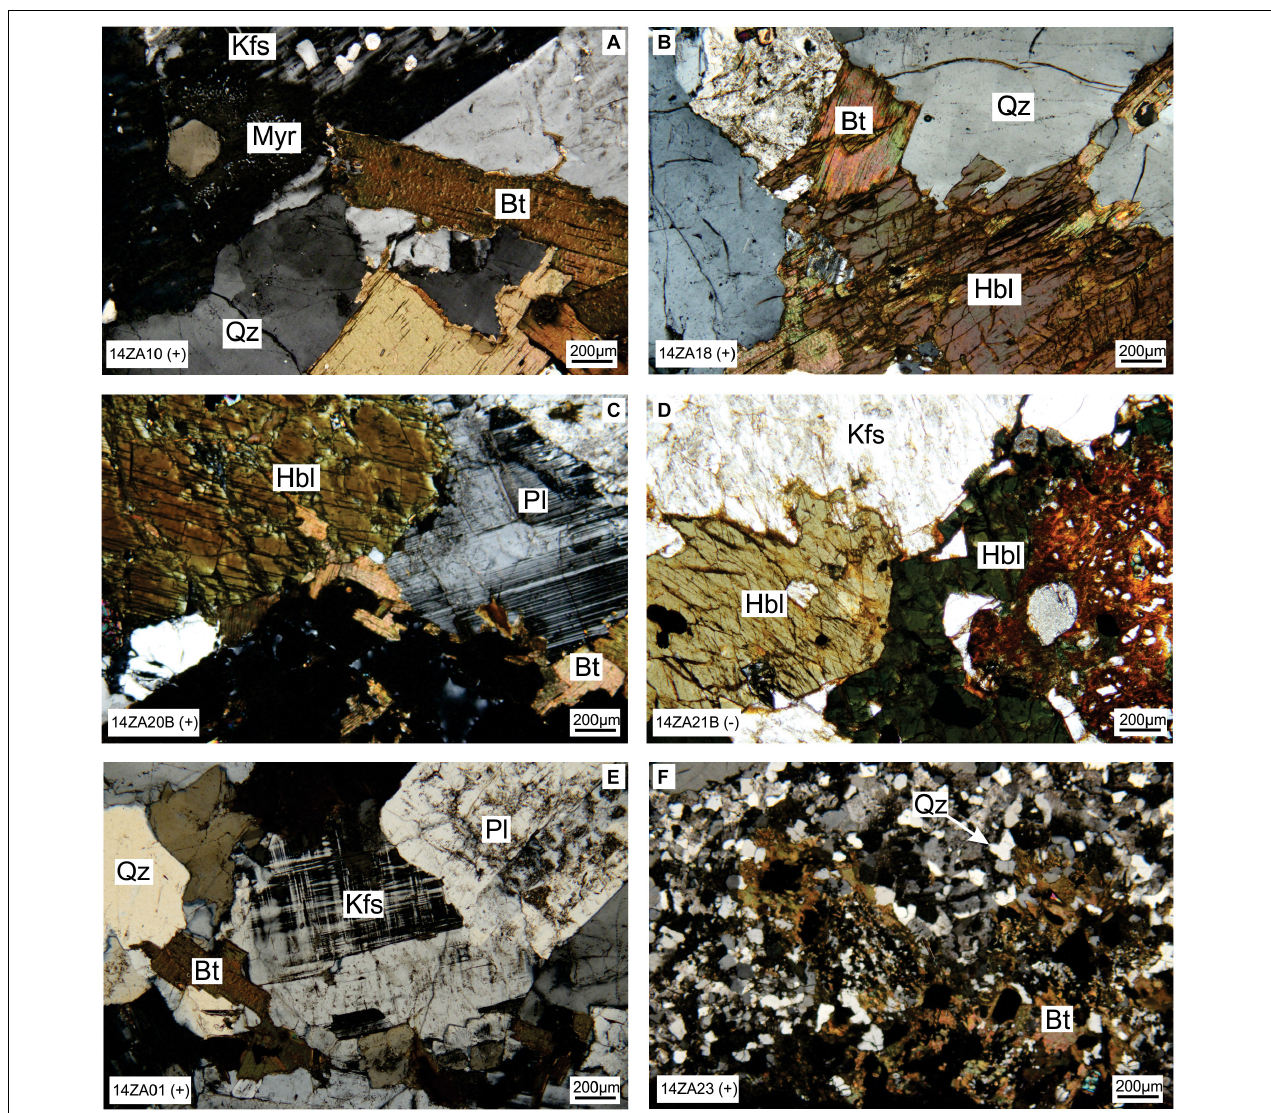
FIGURE 6 | Photomicrographs of the Guéra Massif post-collisional granites under crossed polarizers. (A) 14ZA10, (B) 14ZA18, (C) 14ZA20B, and (D) 14ZA21B of the 560 Ma granites. (E) 14ZA01, and (F) 14ZA23 of the 570 Ma granites. Qz, quartz; Pl, plagioclase; Bt, biotite; Kfs, potassium feldspar; Myr, myrmerkite, Hbl,